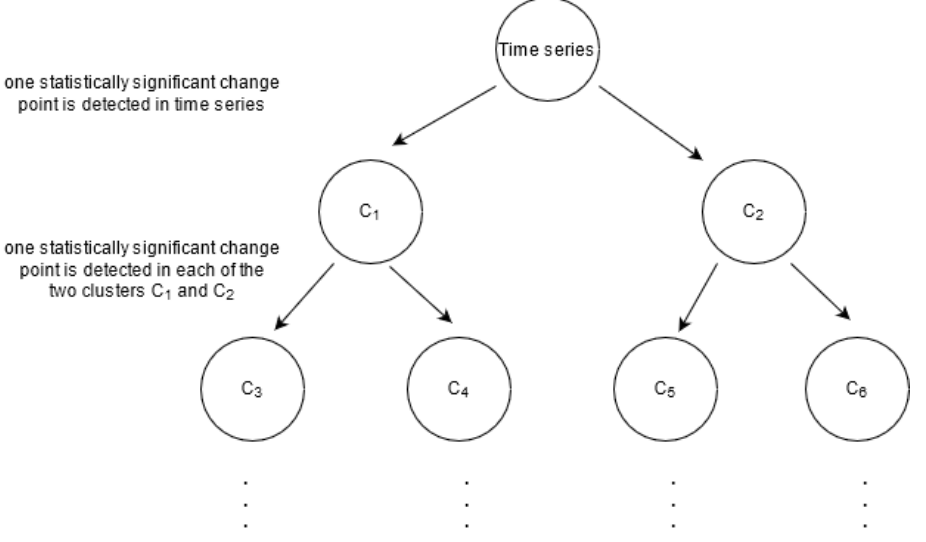
Figure 3. Overview of the CPD algorithm where C i , i = 1,2, . . . , k ( k − 1 is the number of esti- mated change points) denote the clusters of observations that are formulated after the detection of statistically significant change